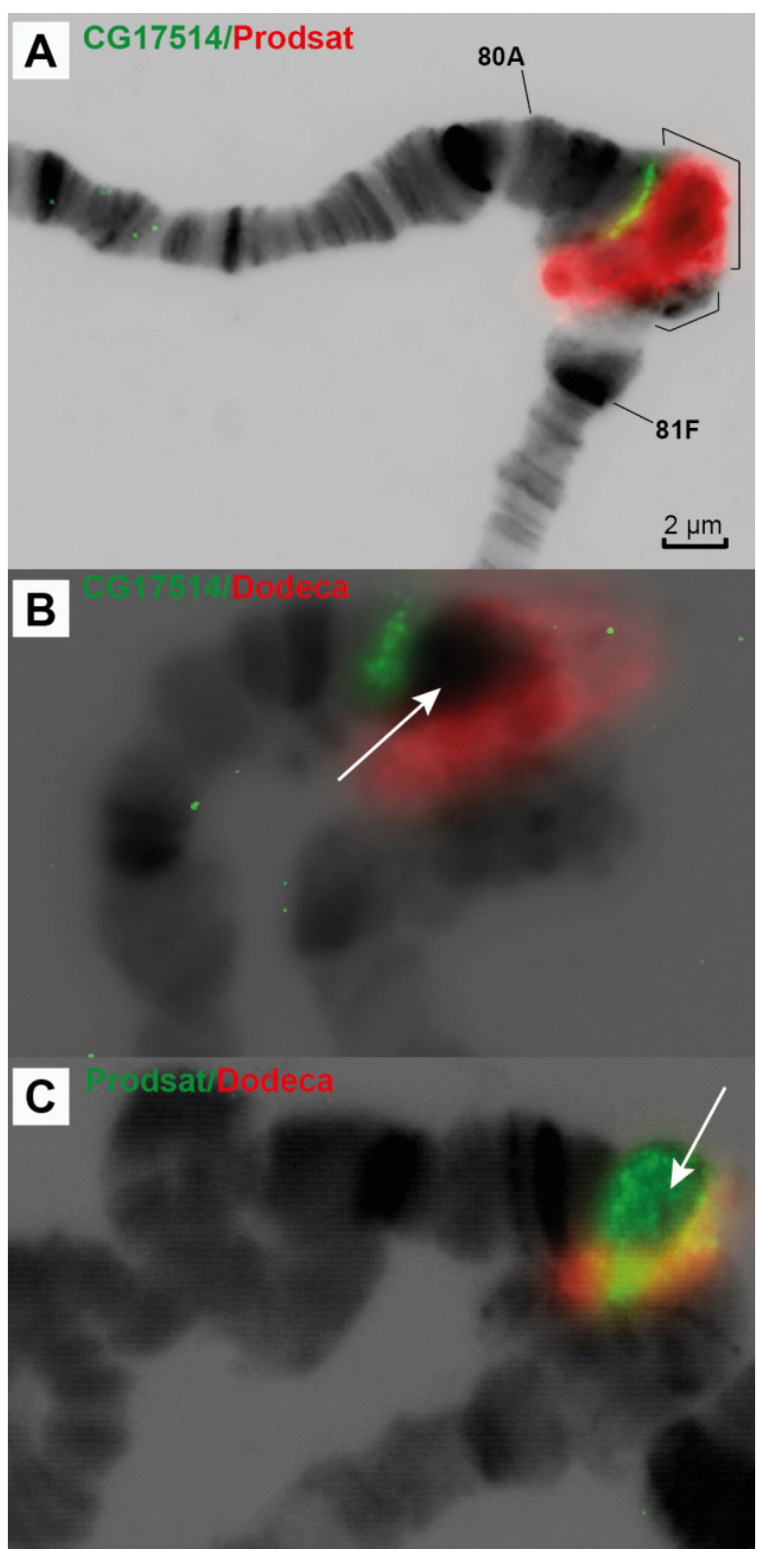
Figure 9. Localization of probes in chromosome 3 heterochromatin: CG17514/Prodsat satellite ( A ), CG17514/Dodeca satellite ( B ), Prodsat/Dodeca satellites ( C ). Brackets in A indicate the Prodsat and Dodeca satellites. White arrows point to the Prodsat satellite. The genotype in all figure parts is Rif1 1 ; SuUR ES Su(var)3-9 06 . Scale bar value is the same for every figure.